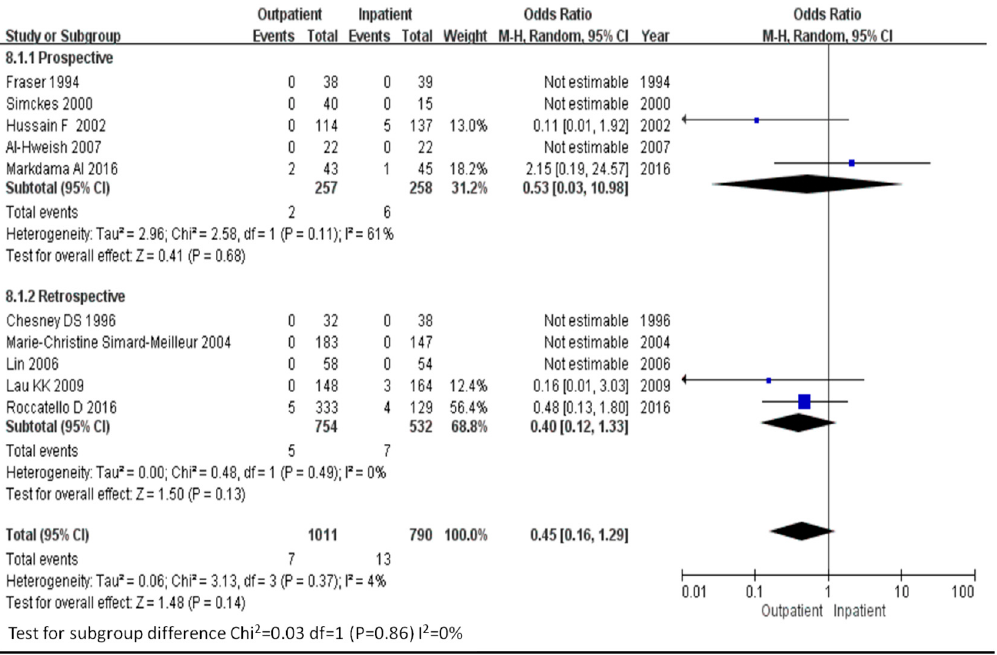
Figure 5. Risk of major events in outpatient renal biopsies compared with inpatient renal biopsies.